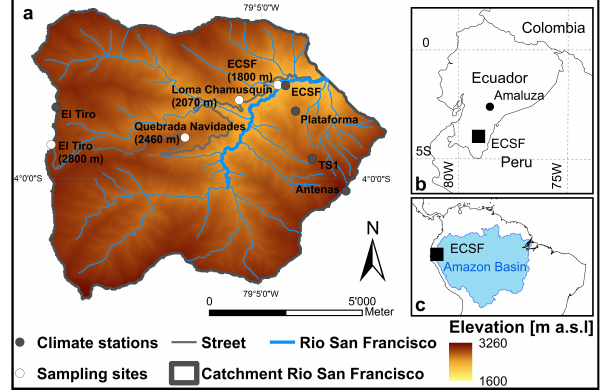
Fig. 1. (a) Investigation area with sampling sites, climate stations and (b) location of the study area within Ecuador and (c) within South